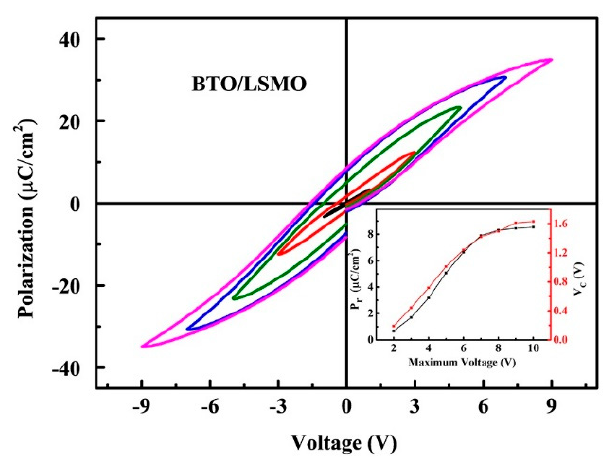
Figure 2. Hysteresis loops of BTO/LSMO films. The inset shows the relationship between coercive field and remanent polarization with the maximum electric field at room temperature.